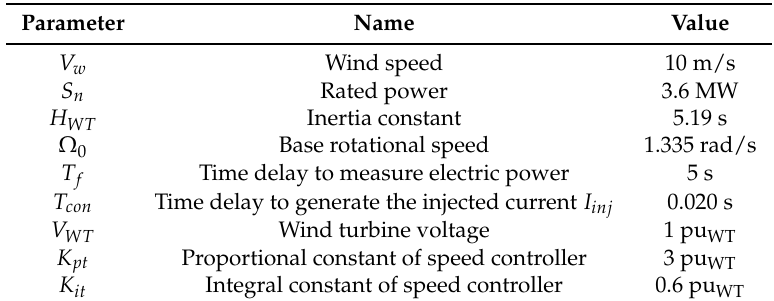
Figure 5. Aggregated wind power plant model with frequency controller. Table 3. Wind turbine parameters